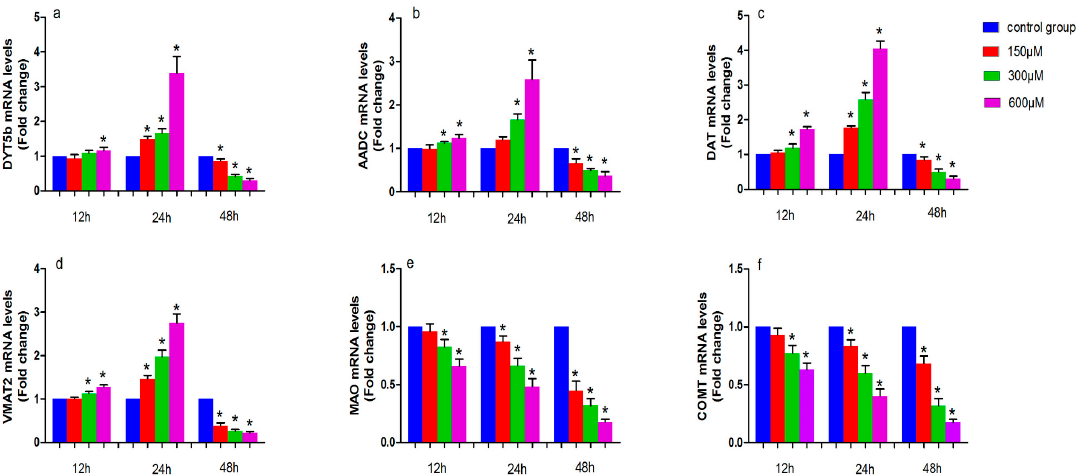
Figure 2. The effects of exposure to simazine for 12, 24, and 48 h on tyrosine hydroxylase (DYT5b) ( a ); aromatic amino acid decarboxylase (AADC) ( b ); dopamine transporter (DAT) ( c ) and monoamine vesicular transporter 2 (VMAT2) ( d ); monoamine oxidase (MAO) ( e ); catechol-O-methyl transferase (COMT) ( f ) mRNA relative levels fold change to control in MN9D cells were presented. Bars indicate mean ± S.E.M. * statistically significant difference compared with the control, * p < 0.05, 3 repeated experiments for each group, n = 3.